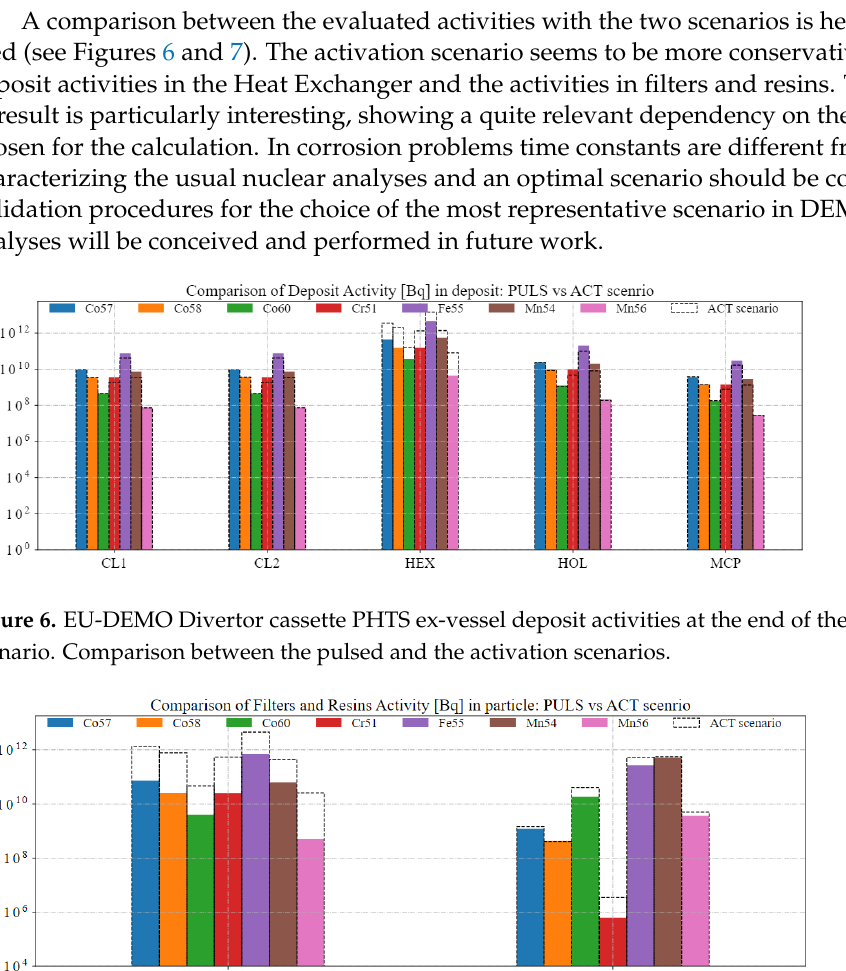
Figure 5. EU-DEMO Divertor cassette PHTS Heat Exchanger deposit activity.